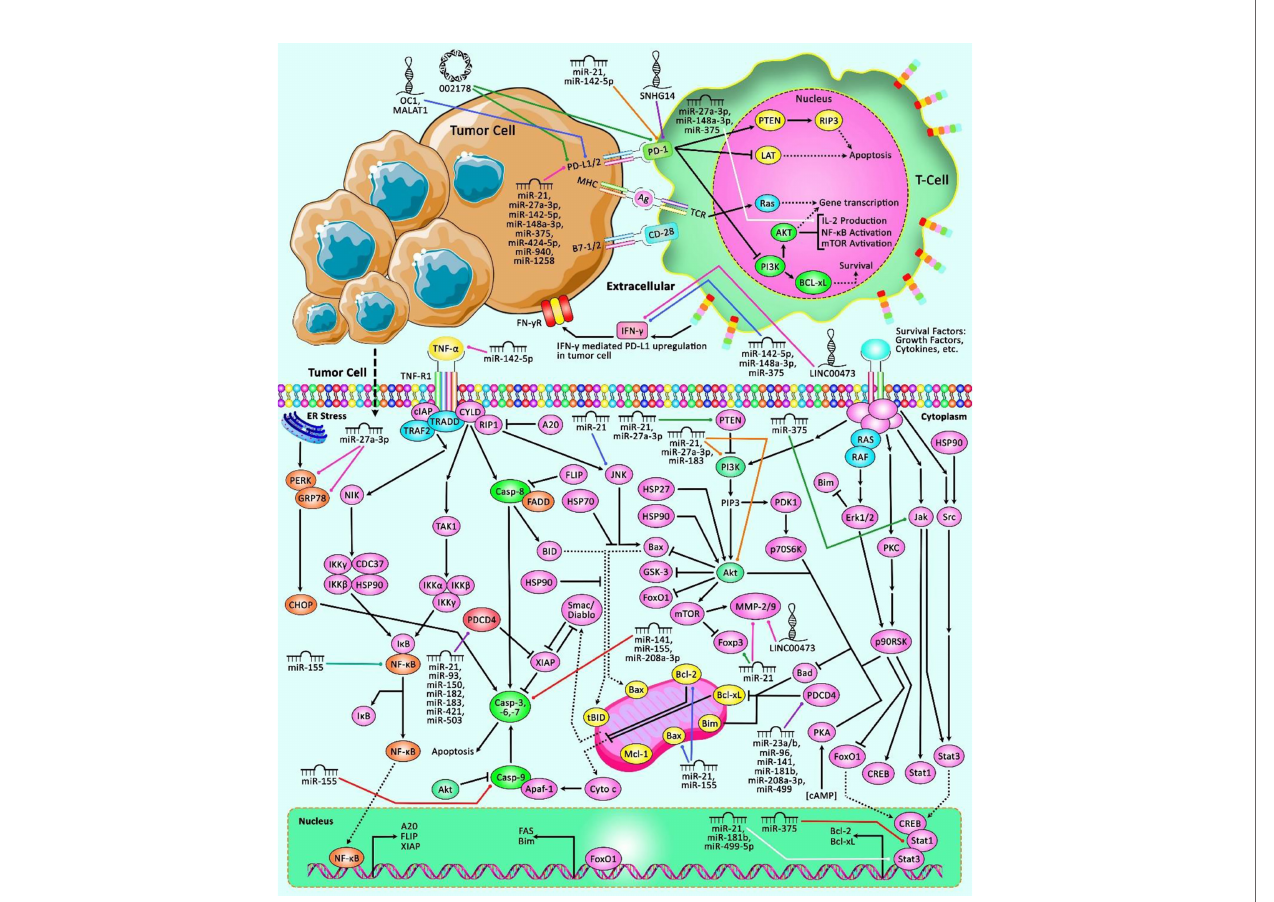
FIGURE 3 | A schematic representation of the role of ncRNAs in modulating the PDCD genes in multiple human cancers. The loss of apoptotic control could cause tumor cells to survive longer and give more time for the accumulation of mutations that could, in turn, enhance invasiveness during tumor cell progression, stimulate angiogenesis, deregulate cell proliferation and interfere with differentiation (95). Apoptosis could be mediated via elevation or suppression of caspases. Besides, the PD-1/PD-L1 interaction could suppress T lymphocyte proliferation, survival and effector functions including cytotoxicity and cytokine release, and thereby could trigger apoptosis of tumor-speci fi c T cells (96, 97). Previous studies have authenticated that several ncRNAs could have a crucial role in human cancers via interacting with various PDCD transcripts. In fact, aberrant expression of these ncRNAs could result in dysregulation of PDCDs, and therefore is associated with different kinds of cancer.